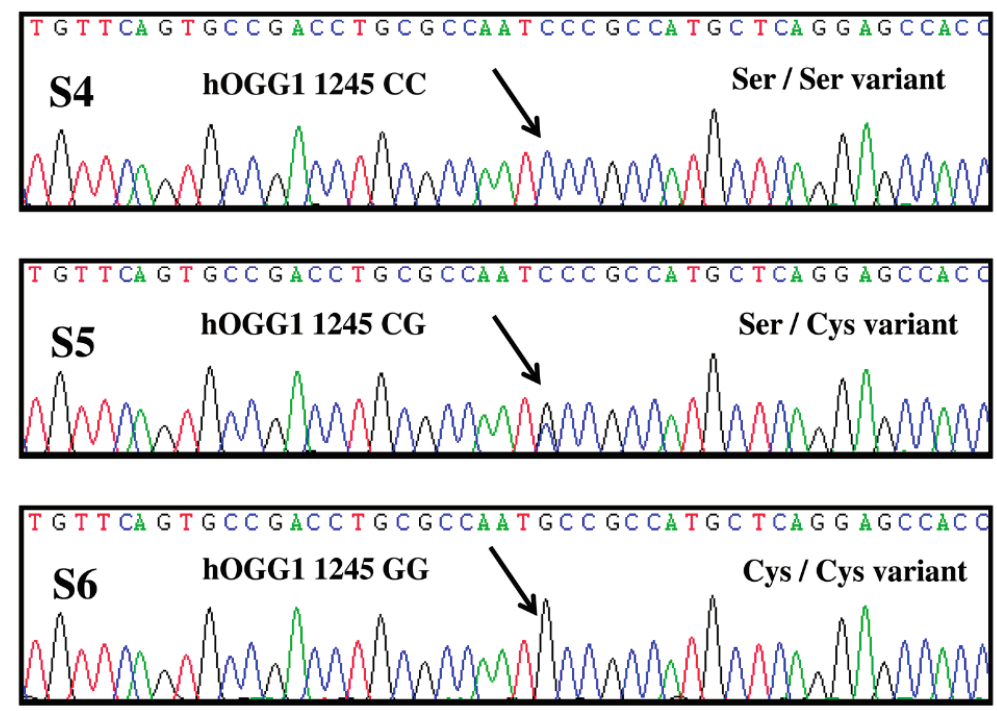
Figure 1. Illustrations are the results of direct sequencing of the DNA segment harboring the hOGG1 gene. Green, red, blue and black colors represent A, T, C and G, respectively. systemic lupus erythematosus (SLE) patient S4 harbored a single C peak at bp 1245